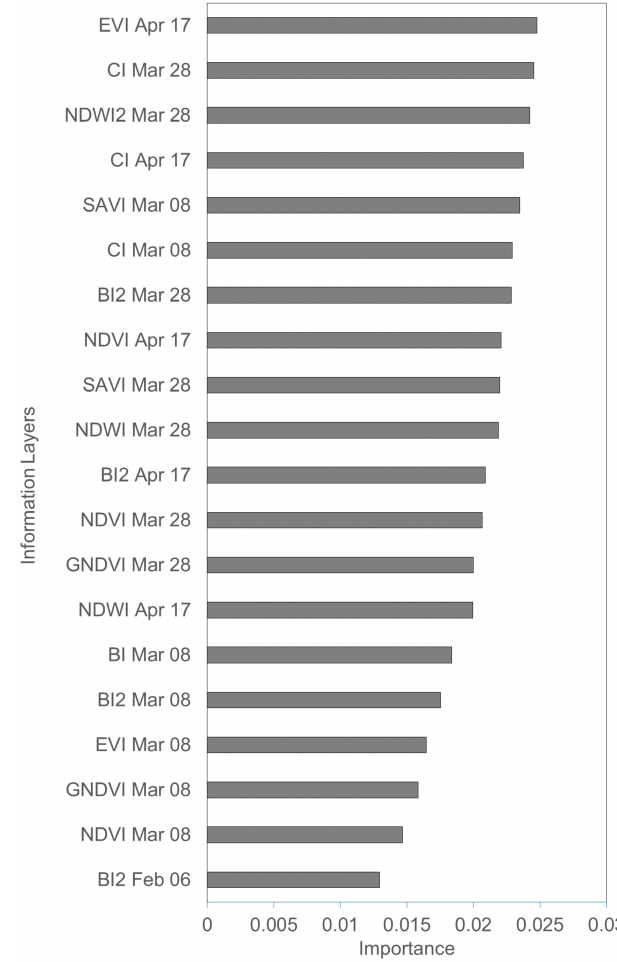
Figure 7. Segments overlaid on a sequence of four false color Sentinel-2 images acquired during the mung bean growing season from February 6 through 17 April 2019. Average size of a segment is 0.02 ha. On the February and March images, bare soil or soil with little vegetation is shown in light turquoise colors. These areas were sown with mung bean in early February and appear in dark pink color in the March 28 and mid-April images.